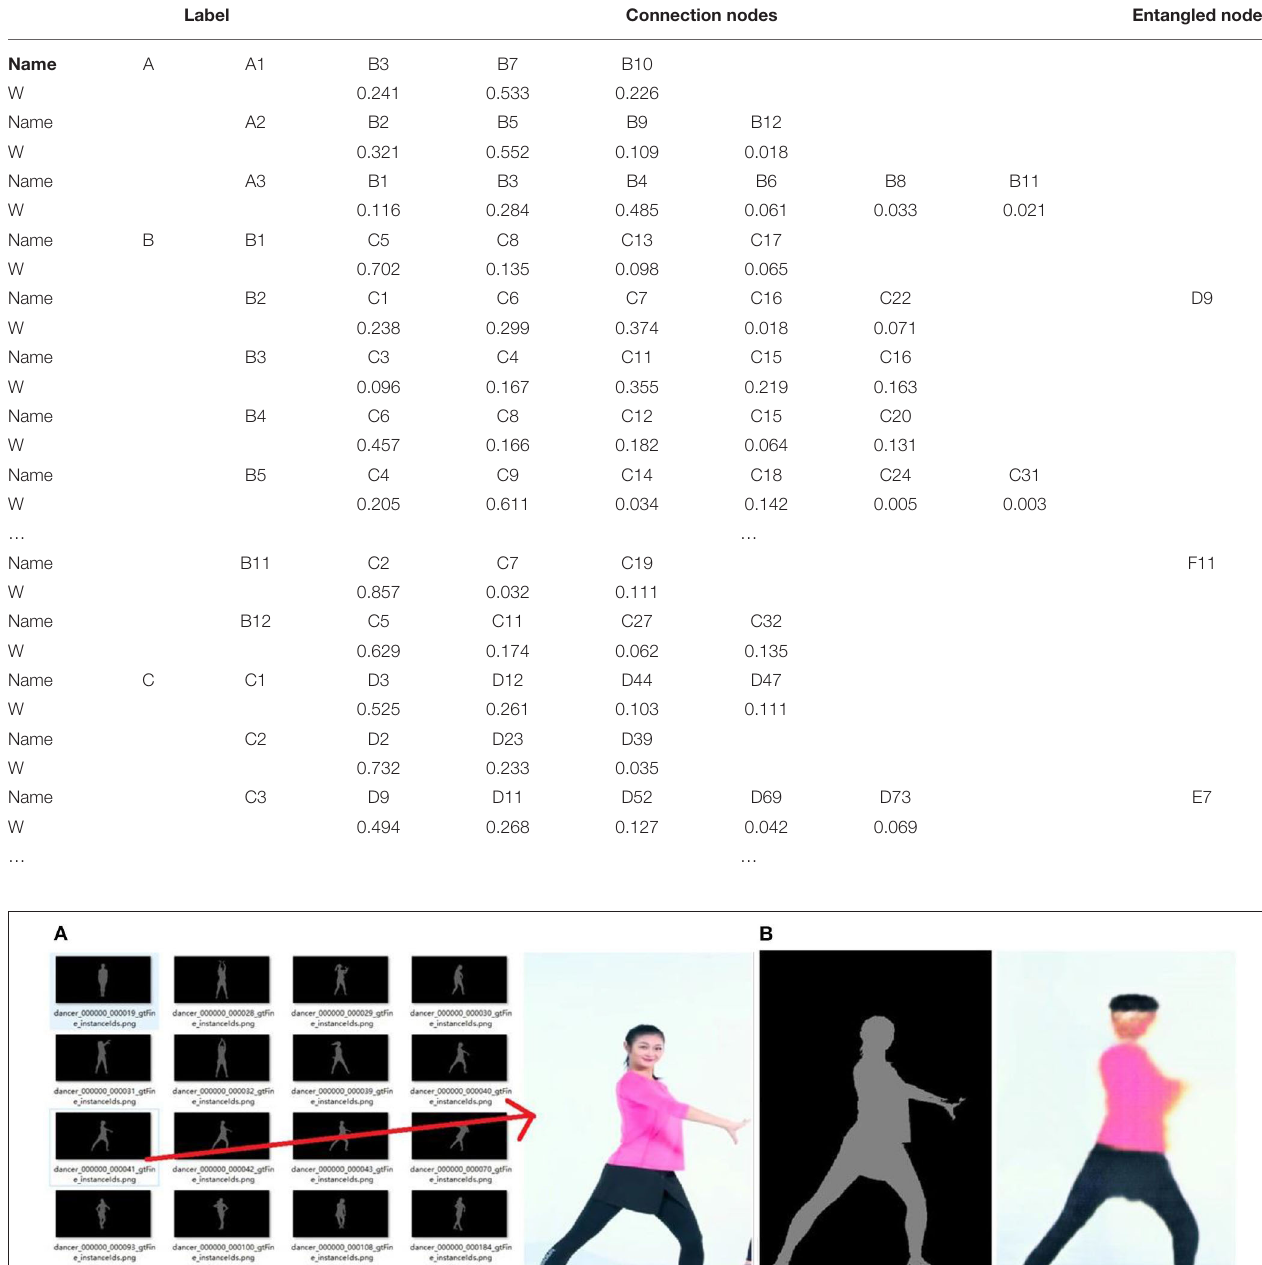
TABLE 3 | Original table of the knowledge graph and weights. Label Connection nodes Entangled nodes